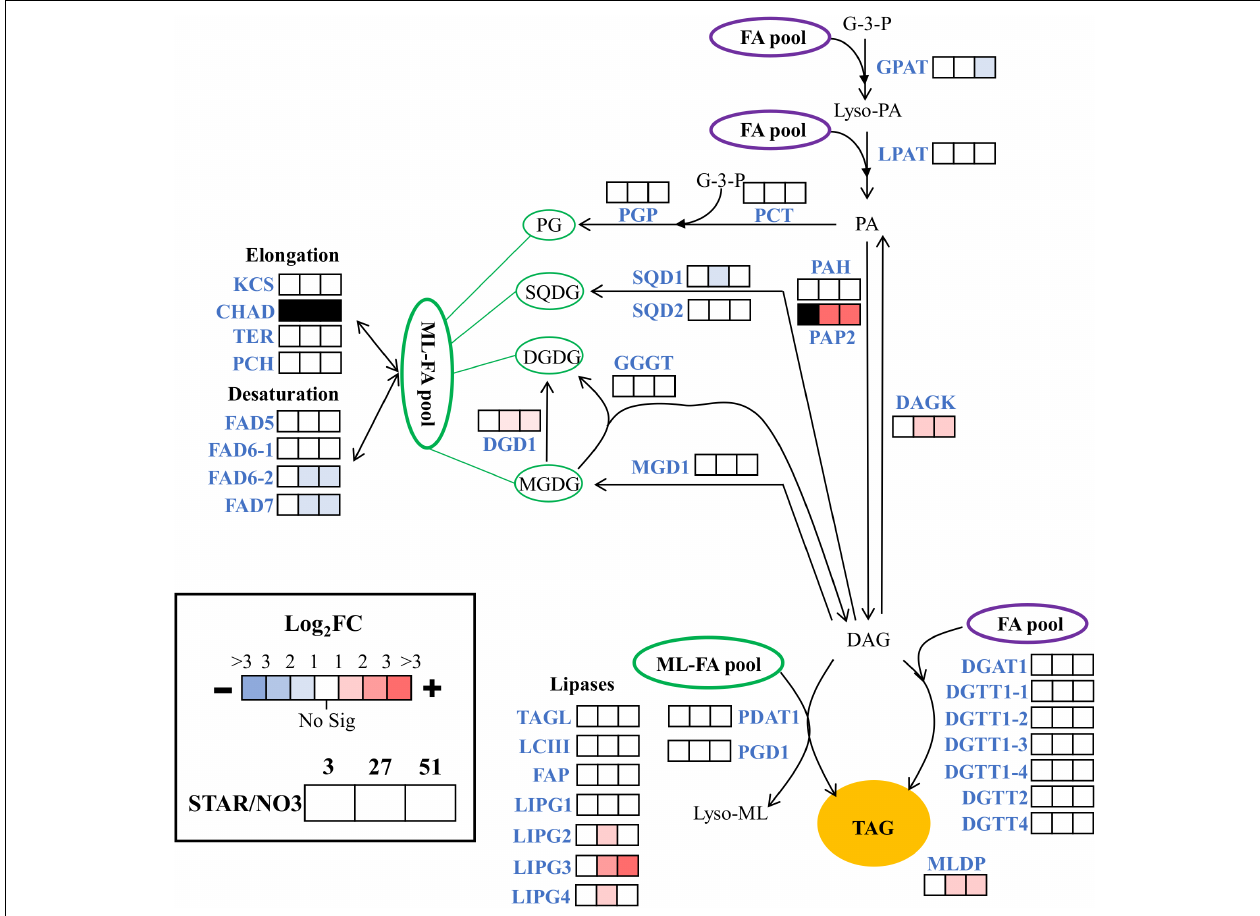
FIGURE 5 | Expression of triacylglycerol metabolism genes during nitrogen starvation. The log 2 fold change values are presented as STAR over NO3 for the 3, 27, and 51 h time points (left to right). Blue represents downregulation in comparison to NO3 and red is upregulation in comparison to NO3. White represents no significant differential expression. Black represents transcripts that lack sufficient raw reads to be trustworthy. Expression data and transcript identities are in Supplementary Data Sheet 1 . Compounds include: PL, polar lipid; G-3-P, glycerol-3-phosphate; Lyso-PA, lyso-phosphatidic acid; PA, phosphatidic acid; PG, phosphatidylglycerol, SQDG, sulfoquinovosyldiacylglycerol; MGDG, monogalactosyldiacylglycerol; DGDG, digalactosyldiacylglycerol; DAG, diacylglycerol; TAG, triacylglycerol. Enzymes include: GPAT, glycerol-3-P acyltransferase; LPAT, lysophosphatidic, acid acyltransferase; PAP2, and PAH, phosphatidate phosphatase; DAGK, diacylglycerol kinase; DGAT and DGTT, diacylglycerol acyltransferase; PCT, CDP-diacylglycerol synthase; PGP, phosphatidylglycerolphosphate synthase; SQD1, UDP-sulfoquinovose synthase; SGD2, sulfolipid synthase; MGD1, monogalactosyldiacylglycerol synthase; DGD1, digalactosyldiacyglycerol synthase; PGD1, plastid galactoglycerolipid degradation 1; GGGT, galactolipid:galactolipid galactosyltransferase; PDAT1, phospholipid:diacylglycerol acyltransferase; MLDP, major lipid droplet protein; KCS, β -ketoacyl-CoA synthase; CHAD, 3-hydroxyacyl-CoA dehydrogenase; TER, Trans -2-enoyl-CoA reductase; PCH, Palmitoyl-CoA hydrolase; FAD5, MGDG specific palmitate (cid:49) -7 desaturase; FAD6, ω -6 fatty acid desaturase; FAD7, ω -3 fatty acid desaturase; TAGL, triacylglycerol lipase; LCIII, class 3 lipase, FAP, class 3 lipase, LIPG, lipase. Modified from Srirangan et al.